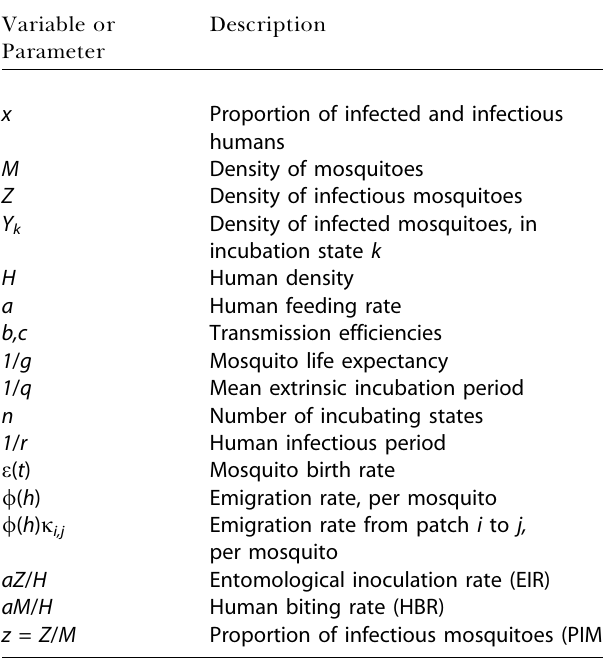
Table 1. Variables and Parameters Used in the Model Variable